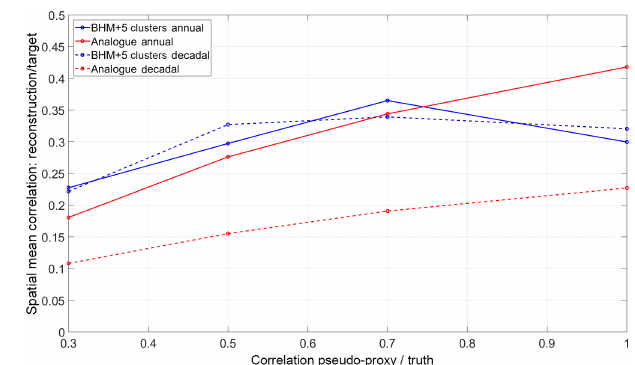
Figure 7. Spatial mean correlation skill of reconstruction tech- niques for different noise levels (expressed here in terms of the cor- relation between the pseudo-proxy and